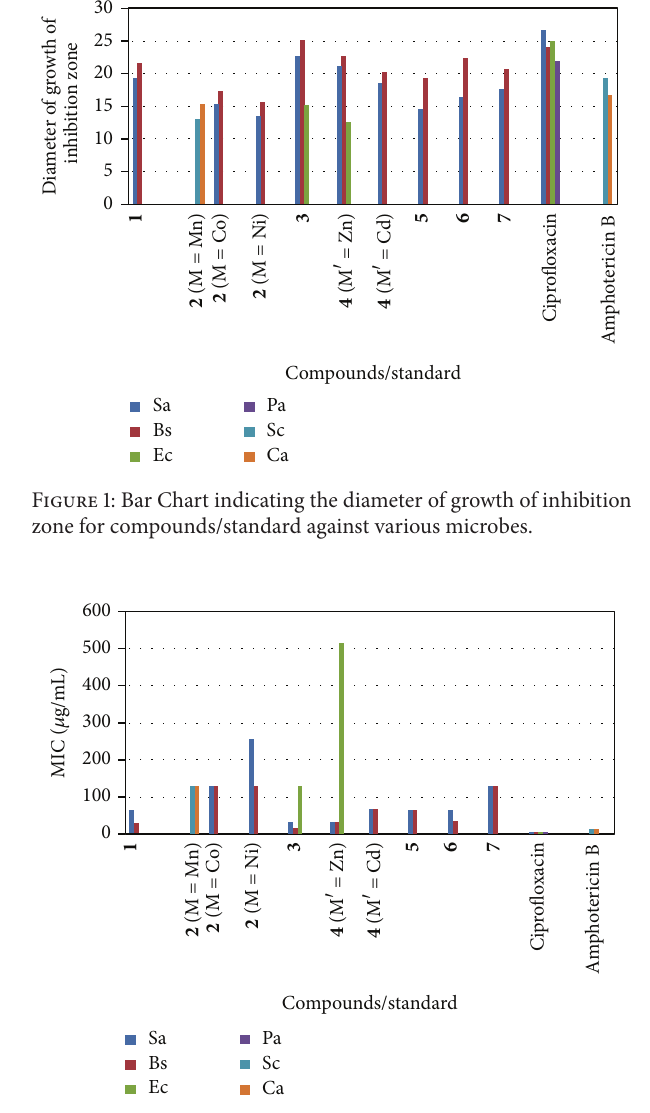
Figure 2: Bar Chart indicating minimum inhibitory concentration (MIC) ( 𝜇 g/mL) for compounds/standard against various